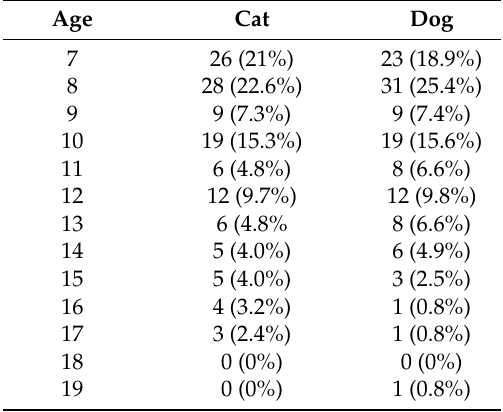
Table 1. Summary of age of cats and dogs included in the sample.